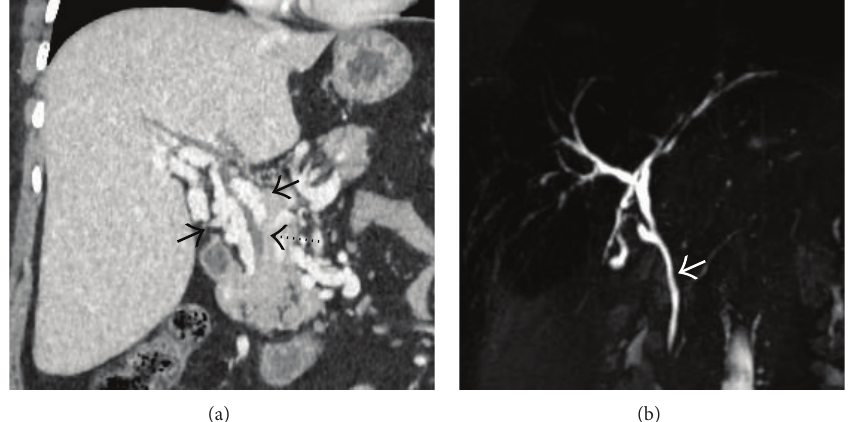
Figure 45: Coronal oblique CECT image (a) showing multiple paracholedochal collaterals (solid black arrows) causing extrinsic compression over the CBD (interrupted arrow). (b) 2D MRCP image of the same patient demonstrating undulating margins of CBD (arrow) due to the